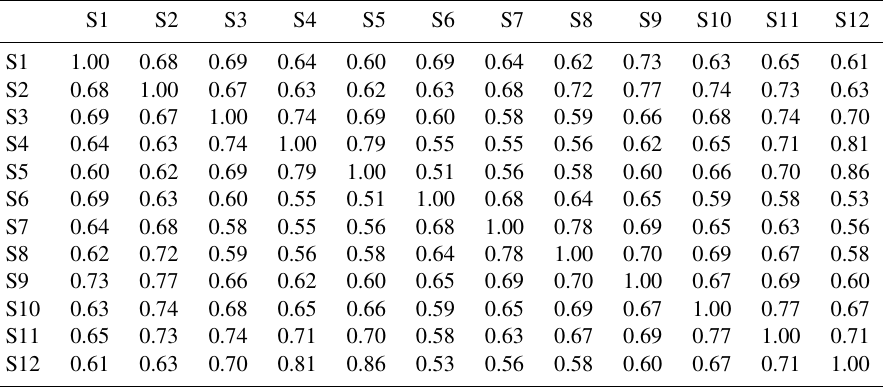
Table 4. Averaged cross-correlation of the 100 simulated series from the DKNNR model for 12 stations from the Yeongnam province, South Korea.